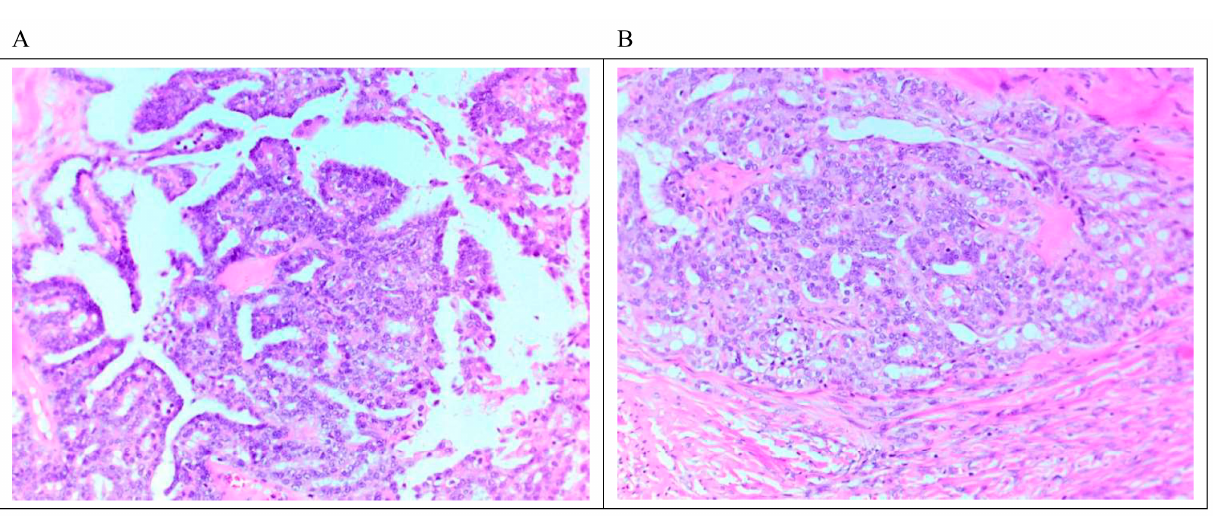
Figure 1. Microscopic feature of LGSC. ( A ) Micropapillary architecture outlined by cuboidal cells with mild to moderate atypia associated with low mitosis. ( B ) Focus on stromal invasion by the tumor with a cribriform architectural pattern. Scale bar 10 μ m (20 × magnification).